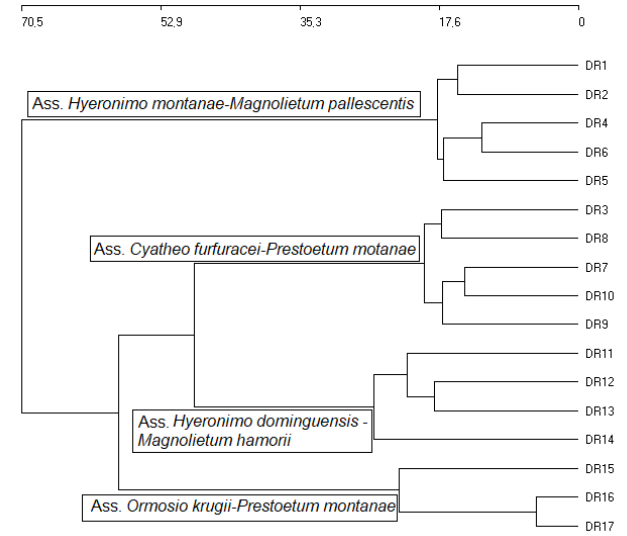
Figure 2. Cluster analysis for the Dominican Republic (DR) relevés. Euclidean distance using Ward’s method separating the four associations (Ass.) found in DR relevés.